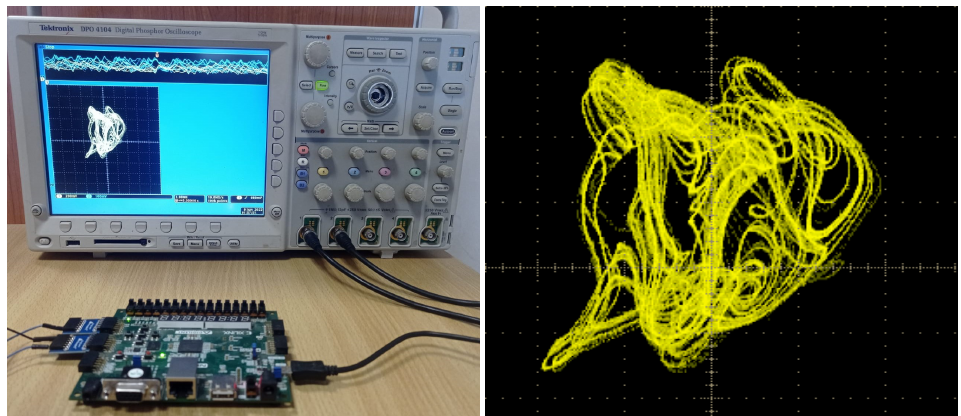
Figure 7. Hardware architecture of the fractional memristive system.